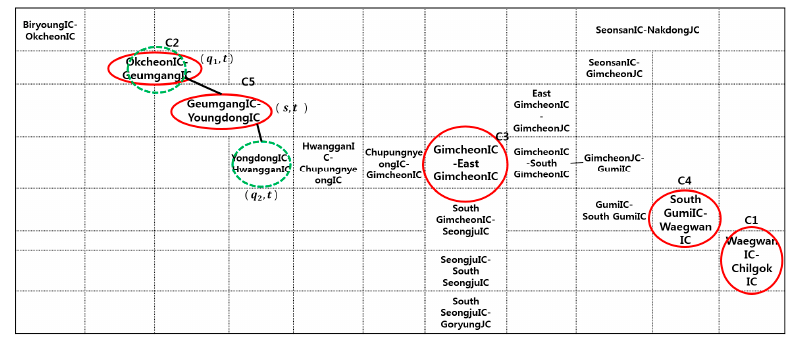
Figure 9. Heat map defined based on the selected five cone zones.